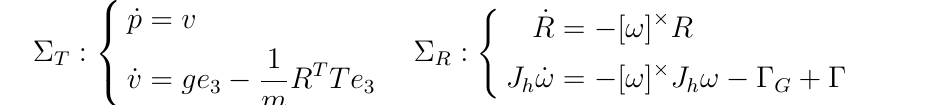
, (cid:126)e b , (cid:126)e b ] 1 2 3